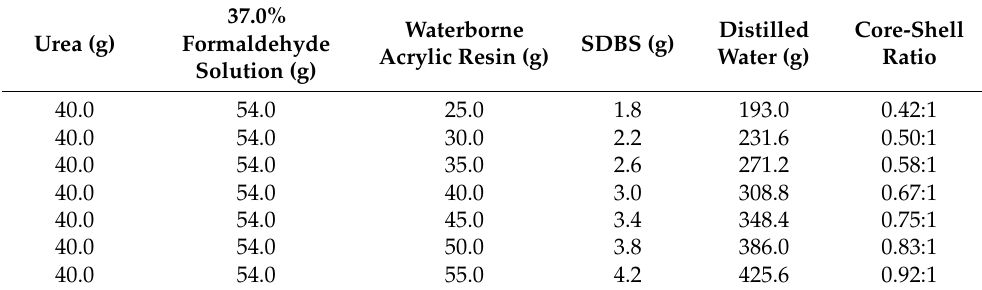
Table 2. Material list of microcapsules with different core-shell